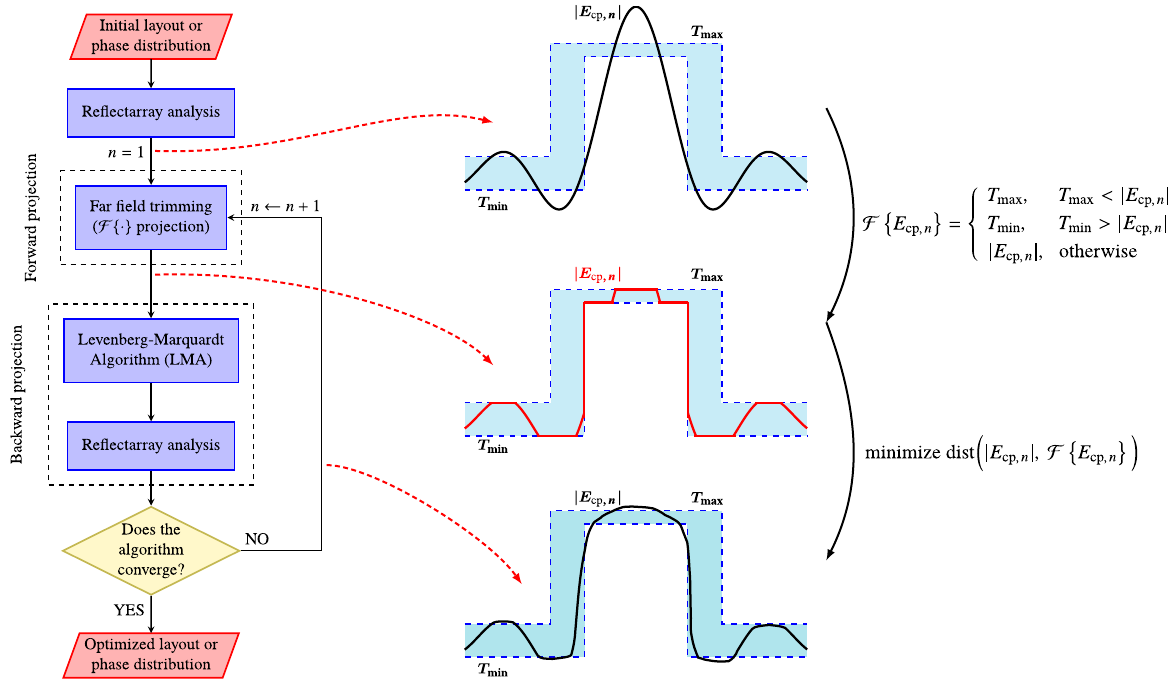
Figure 3. Flowchart of the generalized intersection approach optimization algorithm particularized for reflectarray antennas and a copolar-only synthesis. After the reflectarray analysis, the radiation pattern is obtained. Then, it is trimmed by the forward projection, which imposes the specifications as a set of minimum ( T min ) and maximum ( T max ) templates or masks. Then, the backward projector minimizes the distance between the current far field and the trimmed far field using the Levenberg-Marquardt algorithm. This process is repeated until the algorithm